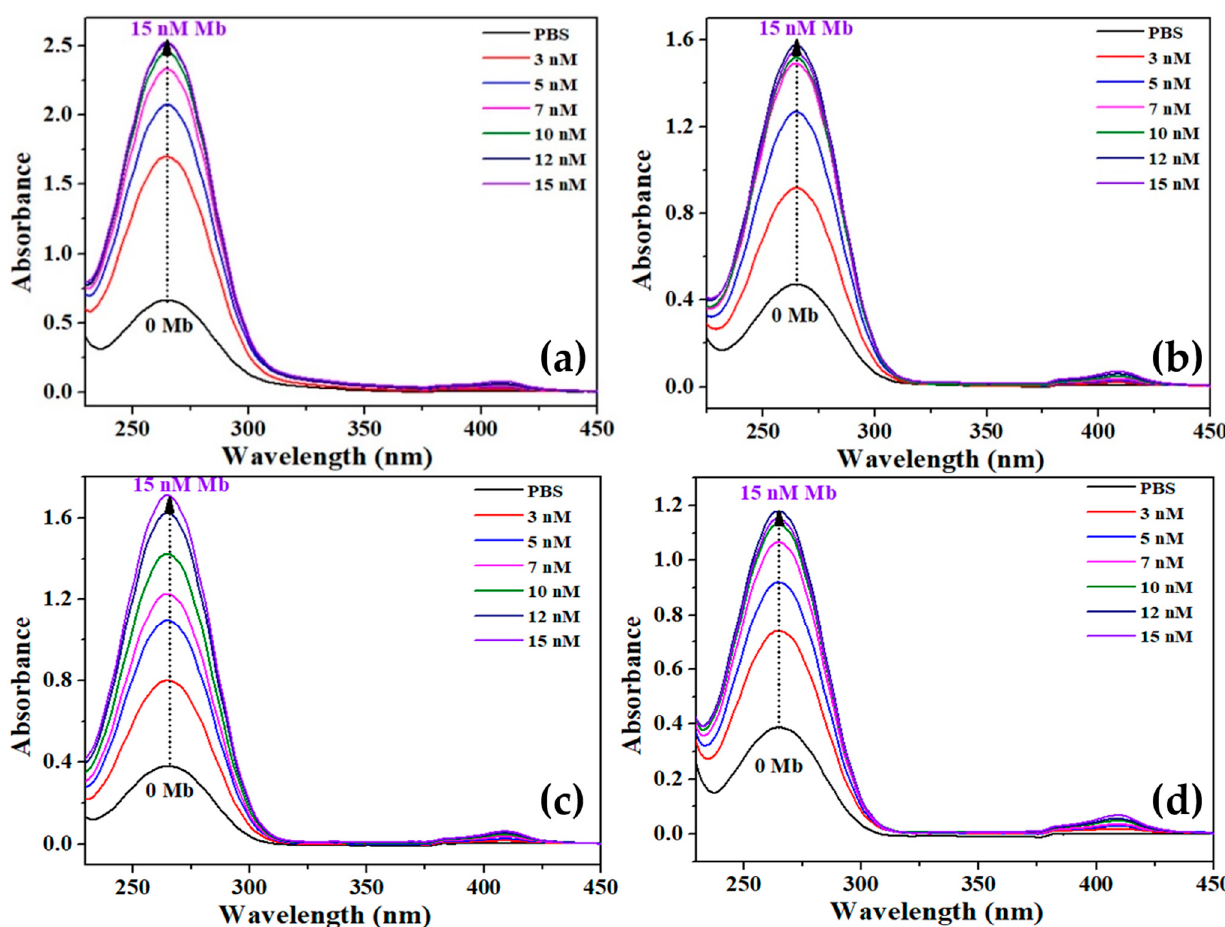
Figure 4. UV–vis absorption spectra of pure and Cu-doped TiO 2 nanomaterials with various concentrations of Mb, ( a ) S0, ( b ) S1, ( c ) S2, and ( d ) S3.